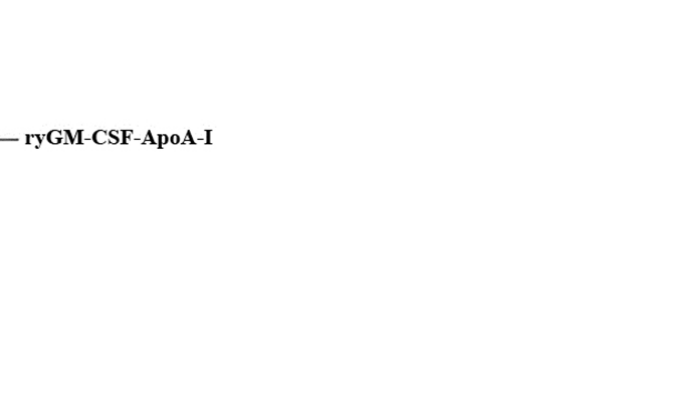
Figure 3. Western blotting of proteins secreted by P. pastoris clone No 3 into culture medium. Lanes: ( M ) the pre-stained standard molecular weight marker (10–150 kDa) (BioRad); ( 1 ) ryGM-CSF-ApoA-I expressed in P. pastoris .